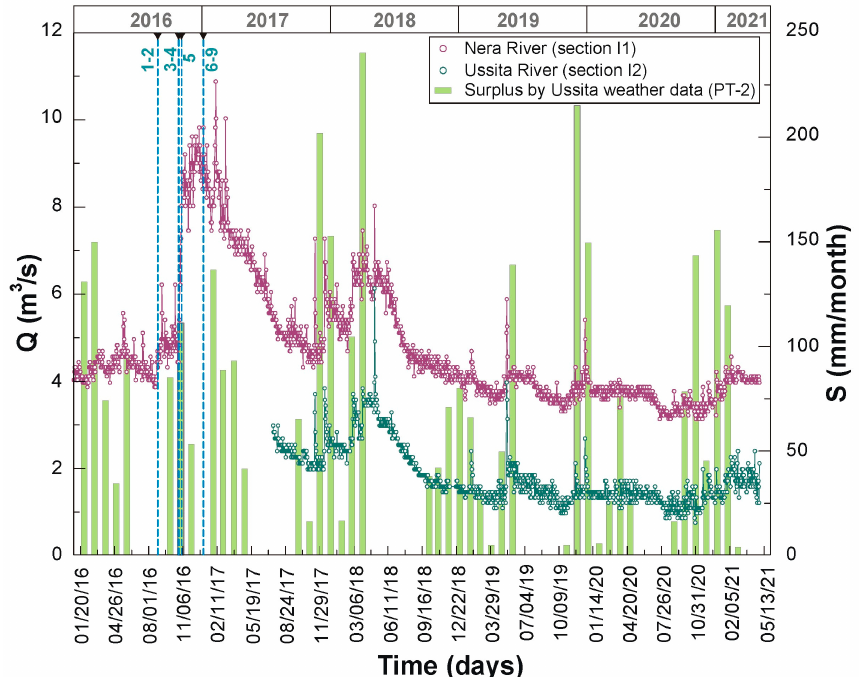
Figure 5. Hydrograph of the Nera River and Ussita River with monthly surplus calculated by using meteorological data of the Ussita station. The blue numbers adjacent to the dashed lines indicate the main earthquakes with moment magnitude (M w ) higher than 5.0 that occurred during the 2016–2017 seismic sequences in Central Italy (information about the earthquakes are reported in Table 1).